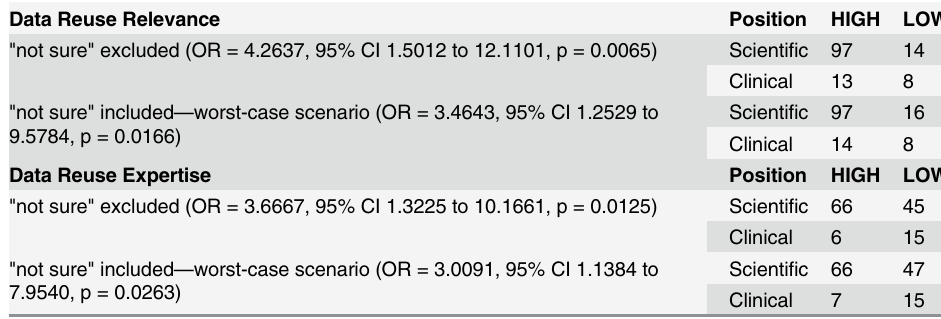
Table 4. Comparison of initial analyses with worst-case scenario analyses.